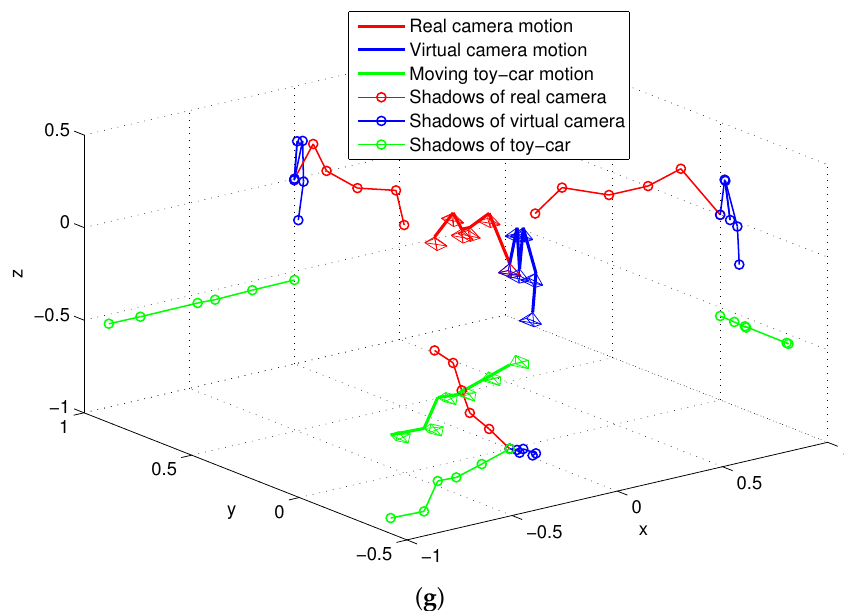
Figure 14. Motion estimation with moving objects in an office-based environment. ( a – f ) typical frames; ( g ) the 3D motion of real camera, virtual camera and moving toy car with 2D shadows.